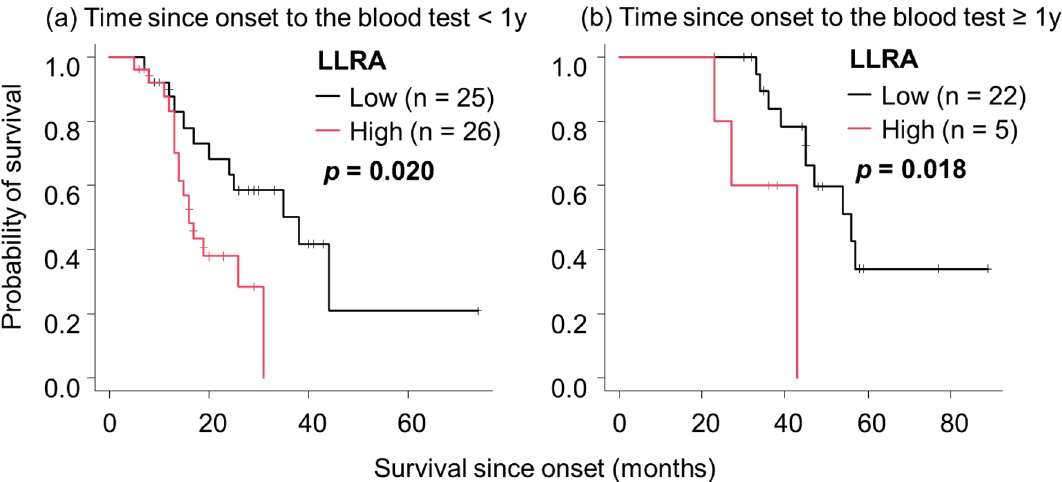
Figure 4. Significance of LLRA as a predictive factor for poor prognosis. Kaplan–Meier analyses and log-rank tests revealed that LLRA was a significant factor for poor prognosis in patients whose time since onset to the blood test was shorter than 1 year ( a ) and in those with an interval longer than 1 year ( b ). Abbreviations: ALS, amyotrophic lateral sclerosis; LLRA, lipid-linked risk for ALS.